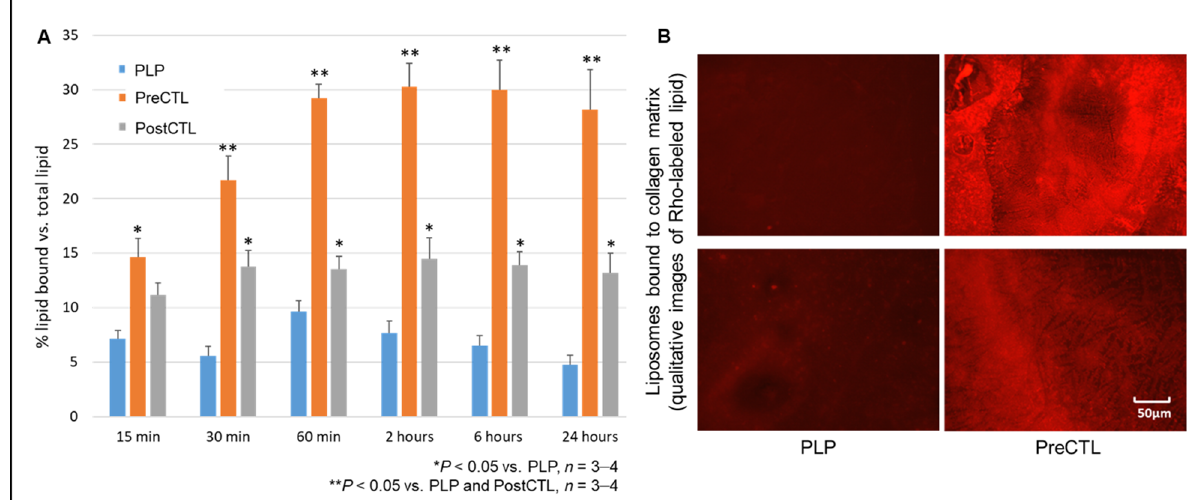
Figure 6. Pre-insertion was determined to be the optimal modification strategy for CT-PLP assembly. ( A ) When 5 mol% CTL was incorporated via pre-insertion (PreCTL), liposome binding was significantly increased over CTL incorporation via post-insertion (PostCTL) and over PLP controls at all time points. Binding was detected by the fluorometry of Rho-labeled lipids, and data in the groups were presented as mean % lipid bound compared to the respective total lipid serial dilution curves at each time point. ( B ) Representative fluorescent microscopy images showing Rho-labeled liposomes bound to collagen IV matrices after 24 h static incubation.